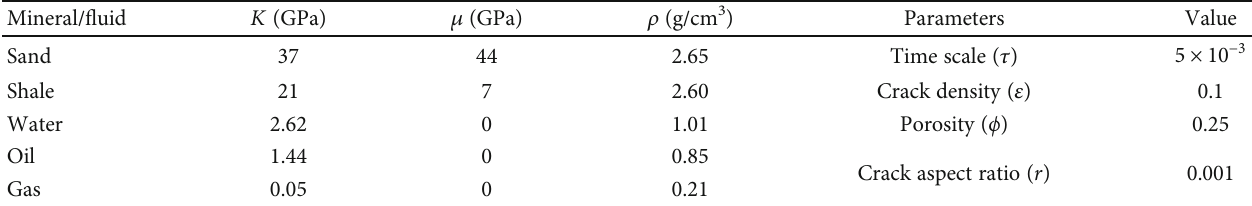
Figure 2: Attenuation analysis of di ff erent elastic parameters. SH indicates shale content, SH = 0 : 2 corresponds to sandstone reservoir and SH = 0 : 8 corresponds to shale reservoir; SG indicates gas saturation in gas-water mixed fl uid and SO indicates oil saturation in oil-water mixed fl uid; K , μ , M , λ , and f indicate the bulk modulus, shear modulus, P-wave modulus, Lamé parameter, and Russell fl uid factor, respectively; the value of γ 2 dry is given as 2.3. (a) Gas-bearing shale reservoir; (b) oil-bearing shale reservoir; (c) gas-bearing sandstone reservoir; (d) oil-bearing sandstone reservoir. Table 1: The used parameter values in the Chapman